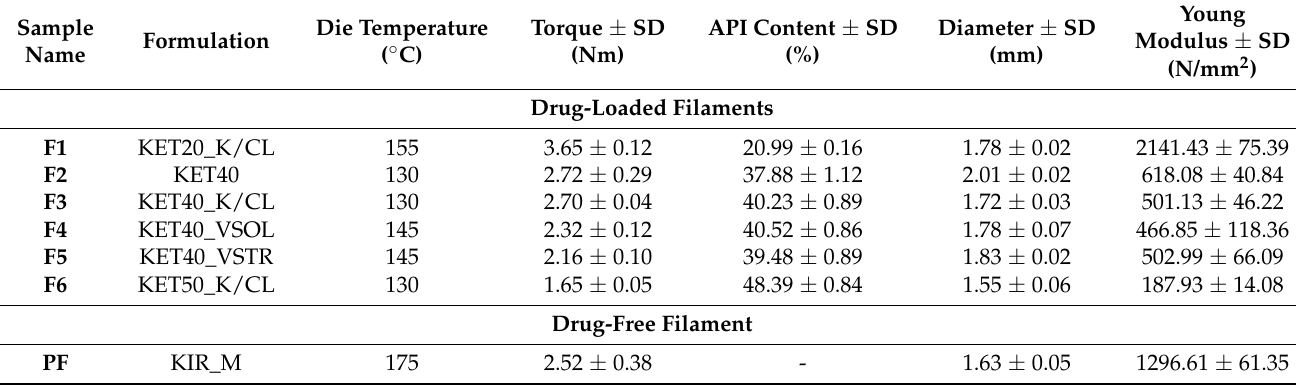
Table 1. Hot-melt extrusion parameters and filament properties (SD is the standard